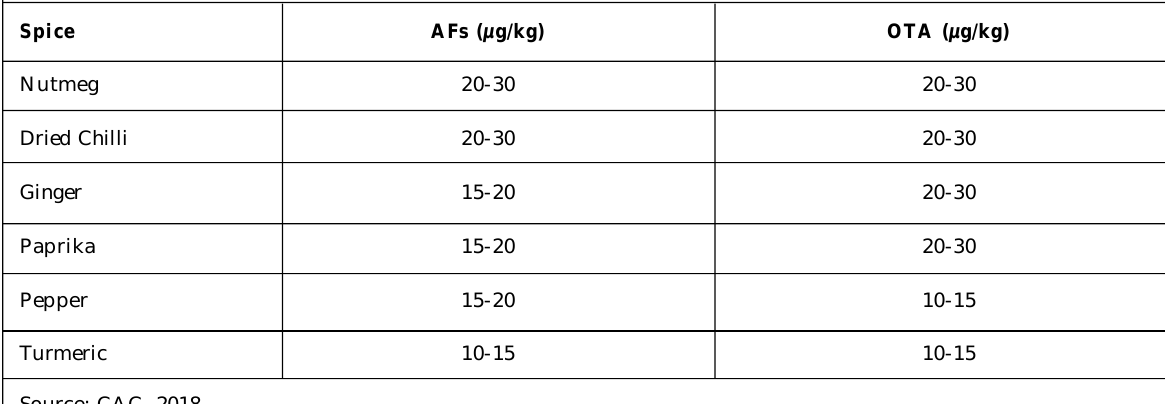
Table 2: Recommended maximum limits by WHO/FAO in the most traded spices globally